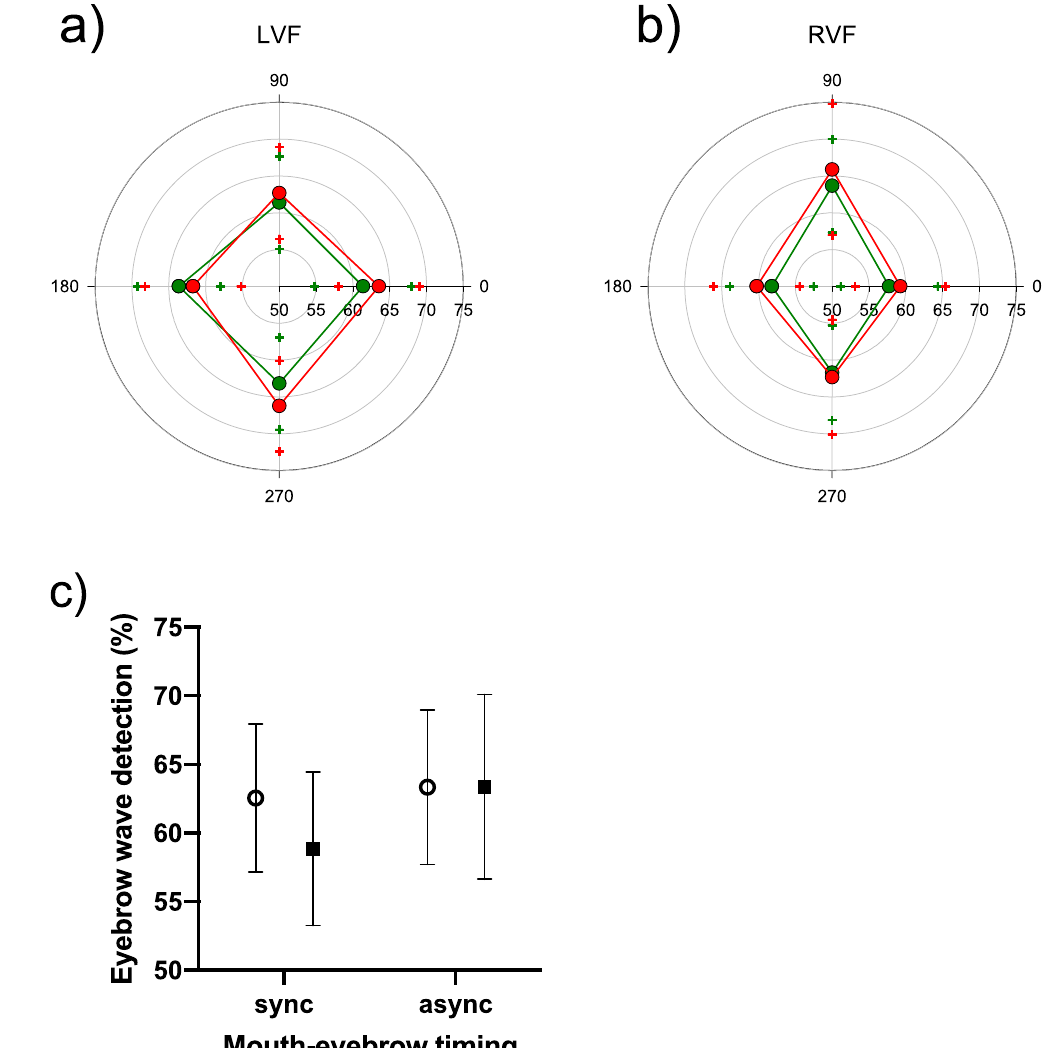
Figure 4. Percent correct for eyebrow wave detection is plotted along the radial axis (starting at 50% correct) as a function of relative phase at test. (a) Sensitivity to misaligned eyebrow movement did not differ significantly across face orientations (red = upright, green = inverted) or eyebrow-mouth relative timings in the left visual field. (b) Performance was poorer for synchronous eyebrow-mouth relative timings (0° and 180°) in the right visual field ( F (3, 63) = 4.05, p = .01, η p 2 = 0.16) supported by a significant hemifield × timing interaction, ( F (3, 63) = 4.32, p = .01, η p2 = 0.17). Crosses in matching colours show upper and lower 95% confidence limits. (c) Data from (a) and (b) collapsed over orientations and feature synchronicity. Open circles = left visual field, solid squares = right visual field; sync = 0° and 180° collapsed, async = 90° and 270° collapsed. Eyebrow wave discriminability was selectively reduced by global facial synchrony in the right visual field ( F (1, 21) = 9.41, p = .01, η p2 = 0.31) but not the left visual field, providing a significant hemifield × synchronicity interaction, ( F (1, 21) = 5.24, p = .03, η p2 = 0.20). All error bars are 95% confidence